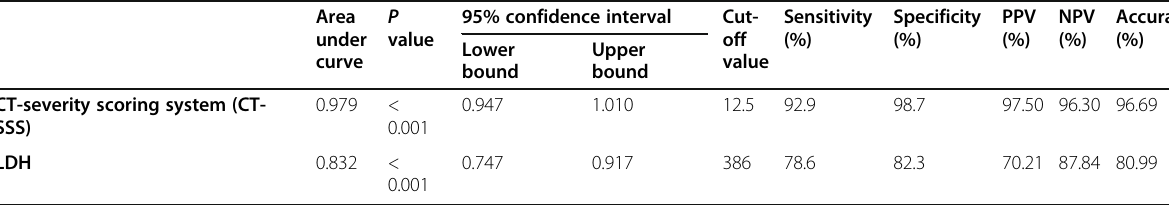
Table 3 ROC curve cut-off value for severe cases using CT-SSS and LDH